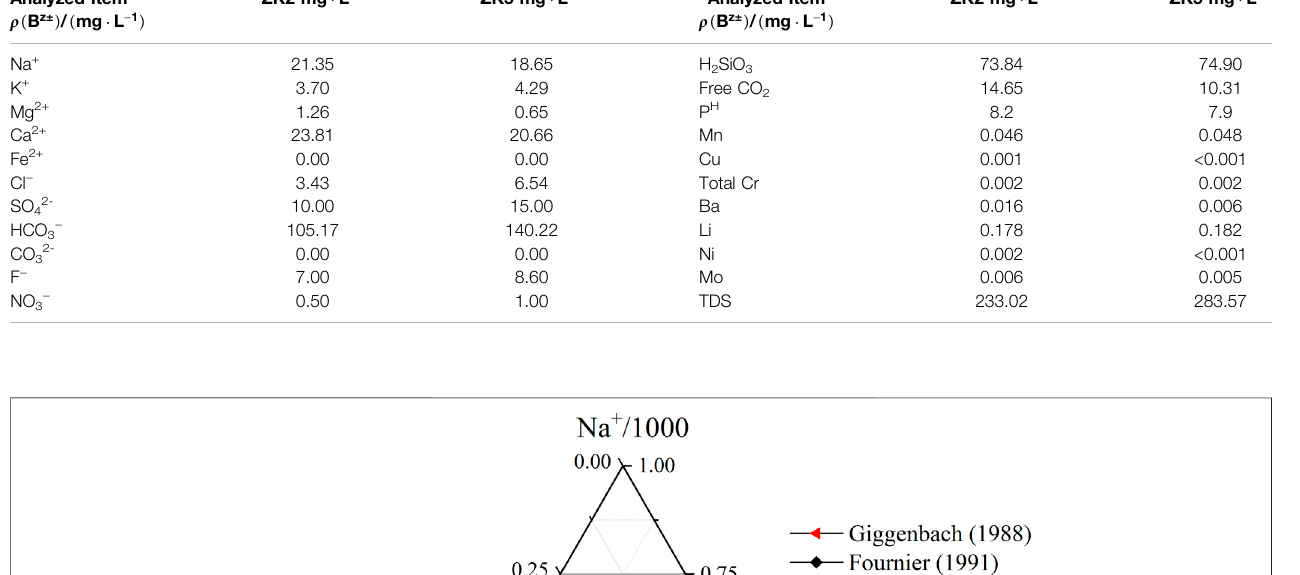
TABLE 2 | Results of chemical analysis of the geothermal water in wells ZK2 and ZK5. Analyzed Item ρ ( B z± ) / ( mg · L − 1 )